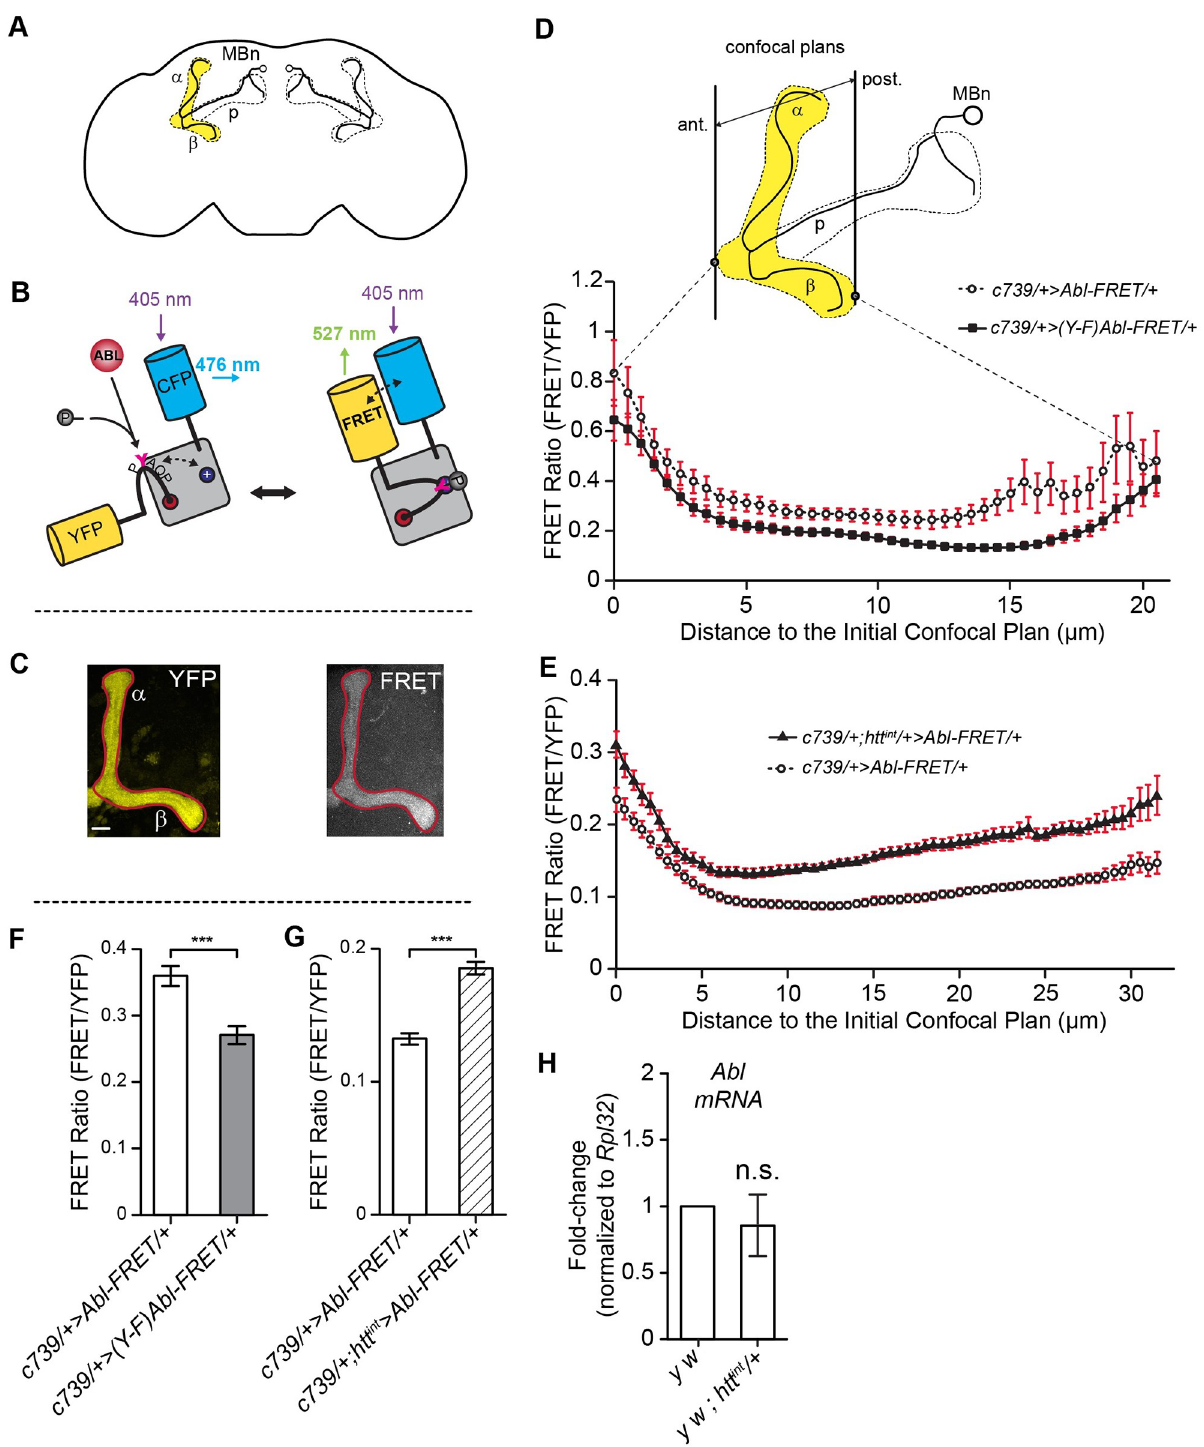
Fig 5. Reducing htt expression increases Abl -FRET biosensor phosphorylation state during MB development. (A) Schematic representation of an imaged MB in the brain. (B) The Abl -FRET biosensor is based on mammalian CRK protein scaffold with two additional fluorescent proteins (CFP and YFP). ABL kinase activity induces phosphorylation of UAS-Abl -FRET biosensor leading to its spatial rearrangement and increased FRET efficiency [59]. (C) Representative maximal projection of the YFP and FRET signals recorded in the MB lobes of adult flies using confocal microscopy. These are presented as examples of the kind of image data that goes into the FRET ratio calculation. Scale bar: 10 μ m. (D) FRET and YFP signals are recorded